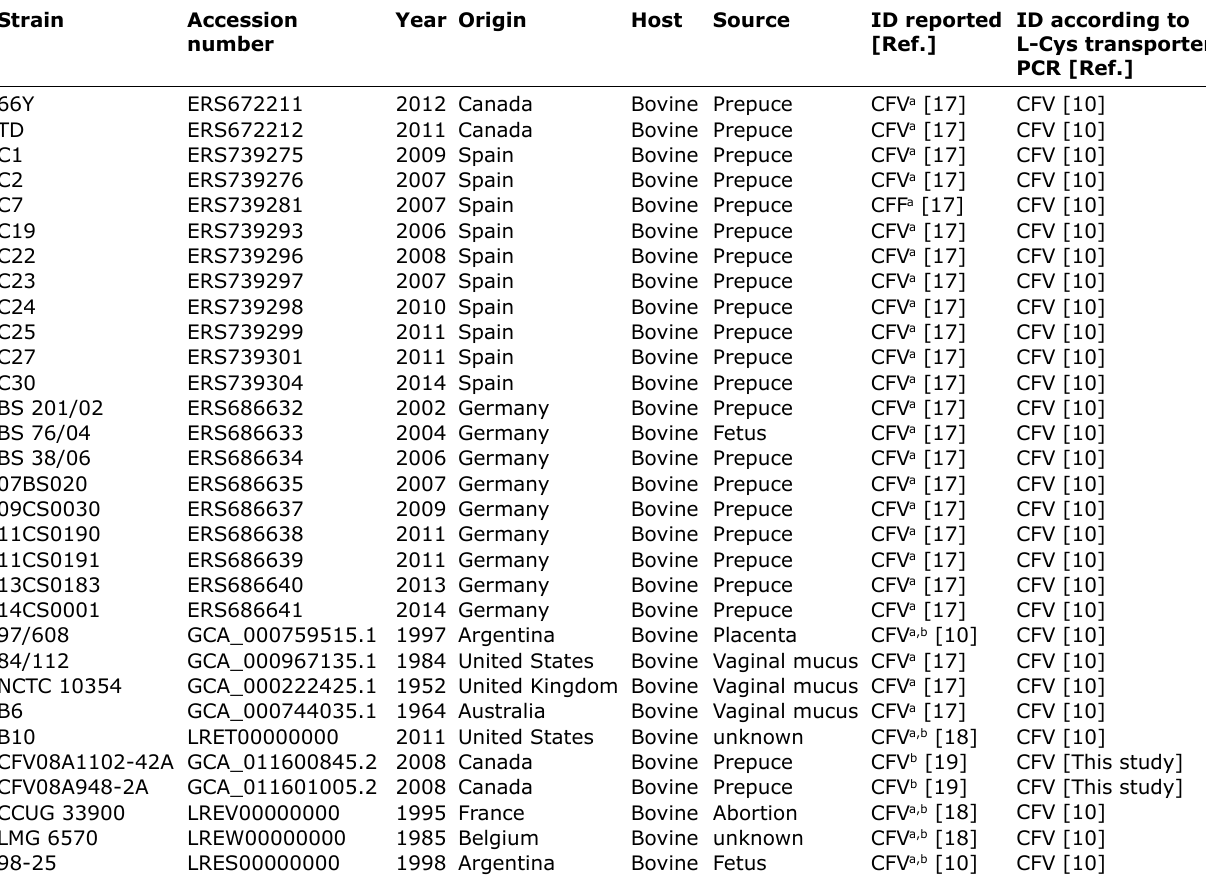
Table-1: Description of strains within the putative Campylobacter fetus venerealis phylogenetic group.